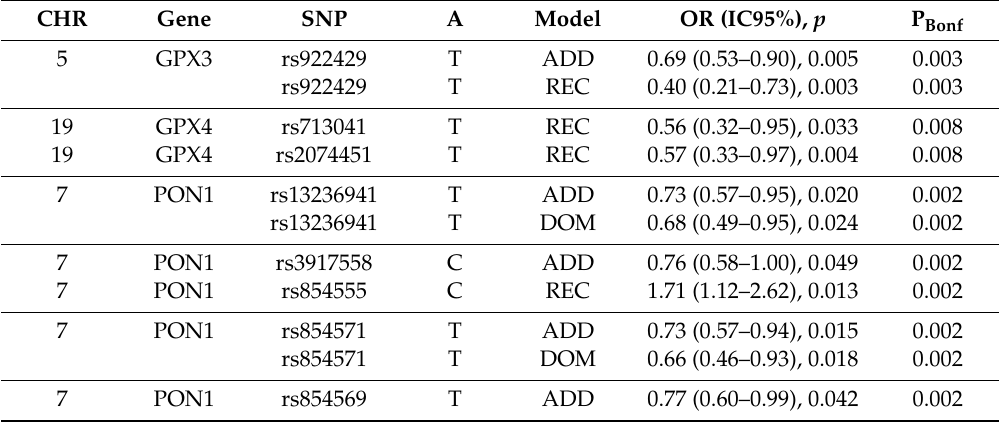
Table 3. Associations between obesity (classified according to percentage of body fat) and antioxidant enzyme-related single nucleotide polymorphisms (SNPs) in Mexican